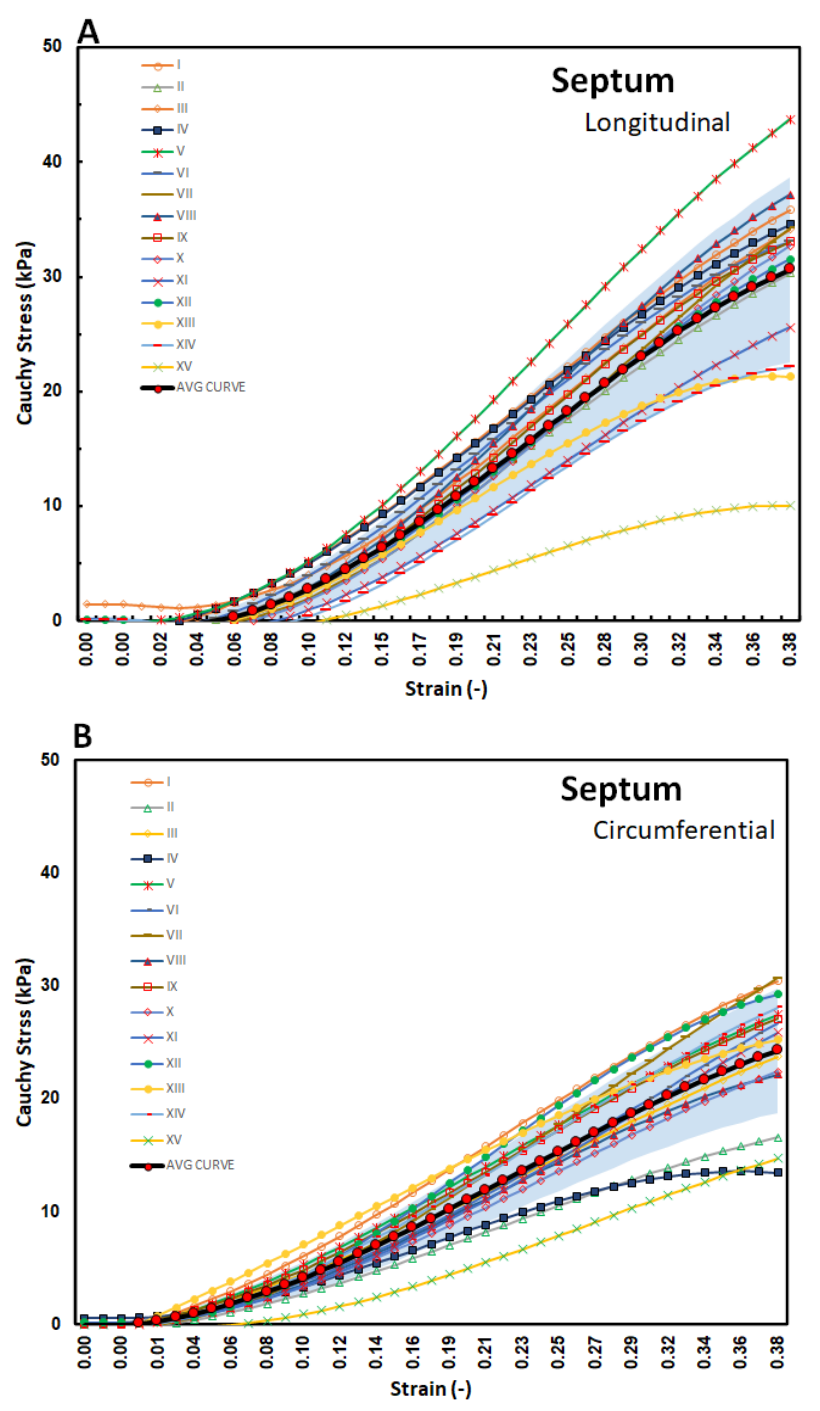
Figure 4. Stress–strain graphs for SPW myocardium in the ( A ) longitudinal and ( B ) circumferential directions overlayed with one-standard deviation regions as well as an average curve.